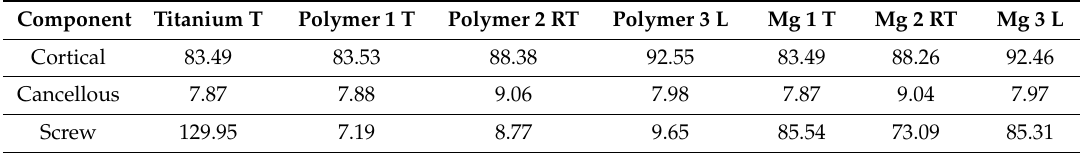
Table 2. Maximum von Mises stress under the given conditions (MPa). Reproduced with permission from [75], Elsevier,